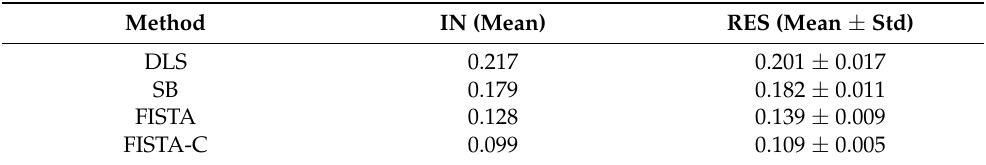
Table 4. Image noise and resolution analysis for imaging results of the four algorithms for a single target at various locations in the head phantom